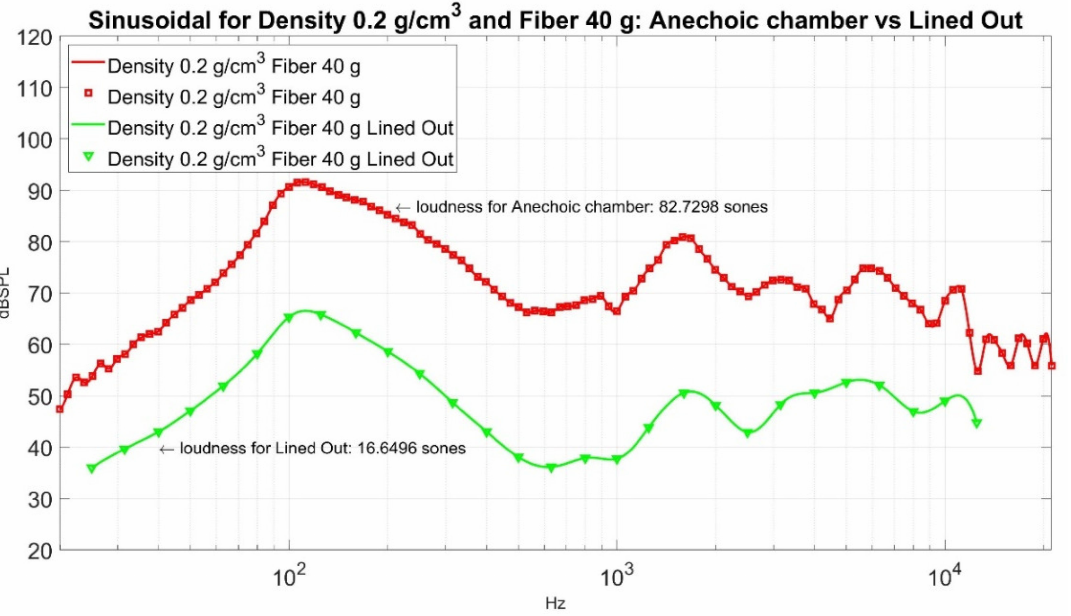
Figure 16. The sound pressure level curves for Density 0.2 g/cm 3 and Fiber 40